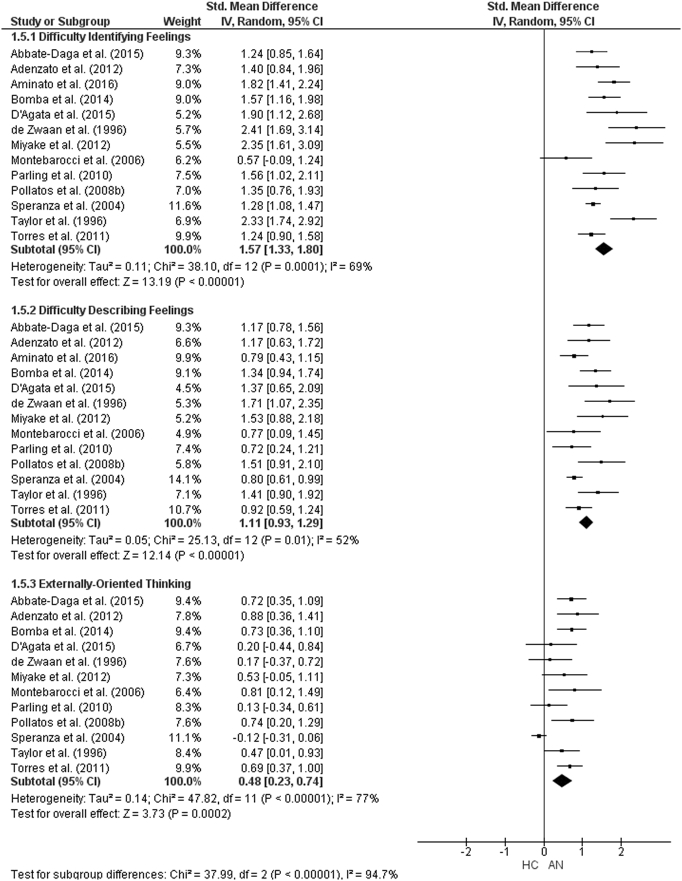
Forest plot of mean TAS subscale scores: standardized mean effect size for differences (SMD) between Anorexia Nervosa (AN) and Healthy Controls (HC). CI, confidence interval.